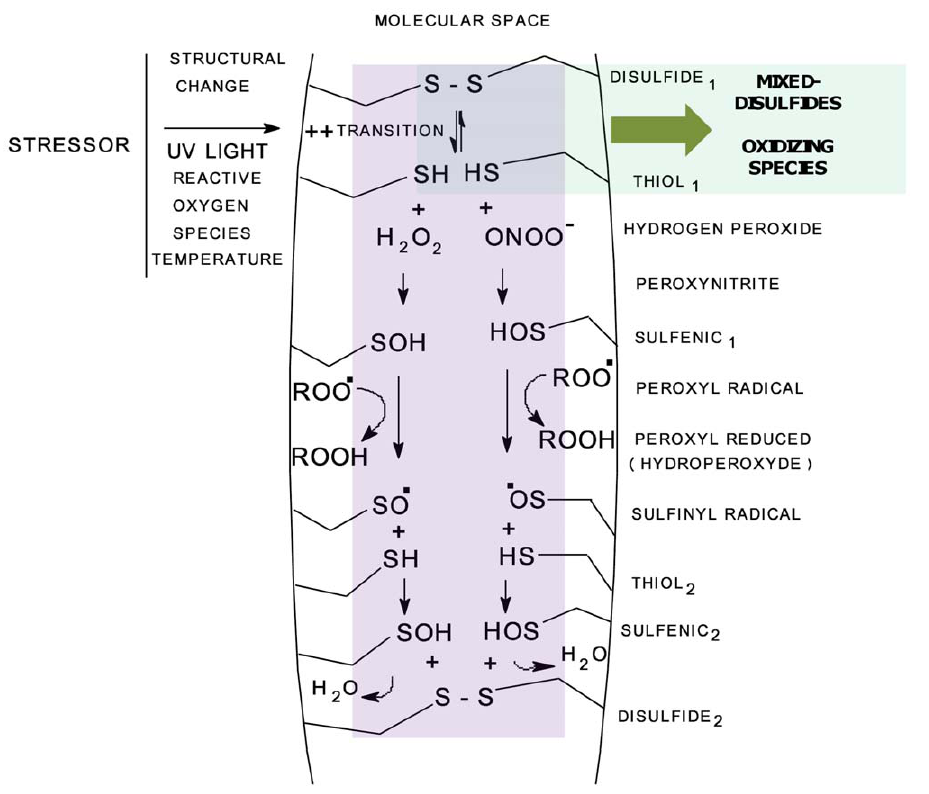
Figure 12. Theoretical model to explain the effect of a stressor on the changes in AC and RS of Human Serum Albumin (HSA). In some places on the molecular space, stressors induce a transition state between disulfide (DISULFIDE 1 ) and thiol groups (THIOL 1 ). Reactive oxygen species (ROS) such as hydrogen peroxide (H 2 O 2 ) and peroxynitrite (ONOO-) can react with thiols to form a sulfenic acid derivative (HSA-SOH) (SULFENIC 1 ). The Sulfenic group is an efficient reducer of peroxy radicals (ROO) and reacts with it to form a sulfinyl radical derivative (HSA-SO) and the correspondent hydroperoxyde (ROOH). A new sulfenic acid derivative (SULFENIC 2 ), this time formed by the reaction of previously formed HSA-SO . with new thiol groups (THIOL 2 ), completes the cycle with the formation of additional disulfides (DISULFIDE 2 ). Protein requires space to move itself between transition states (flexibility). The precise localization of cysteine residues facilitates the cycle. The driven force to move the entire system depicted should be the more favorable thermodynamic molecular state derived from the primary structure. Pale green = passive component; pale violet = active component or structural change dependent. Intersection is common to both components.